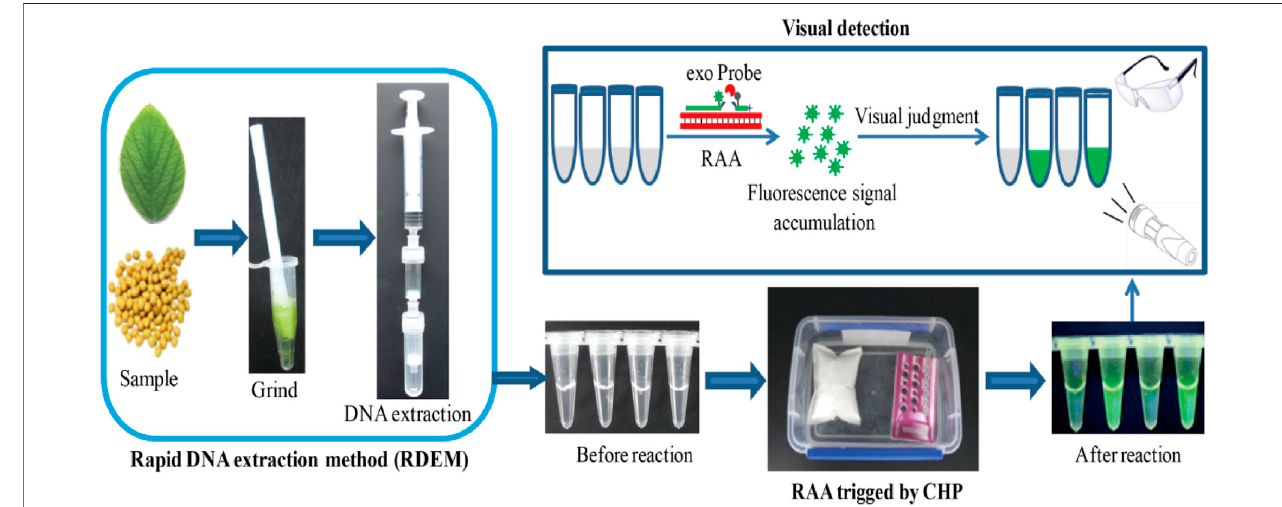
SCHEME 1 | Schematic diagram of the RRC